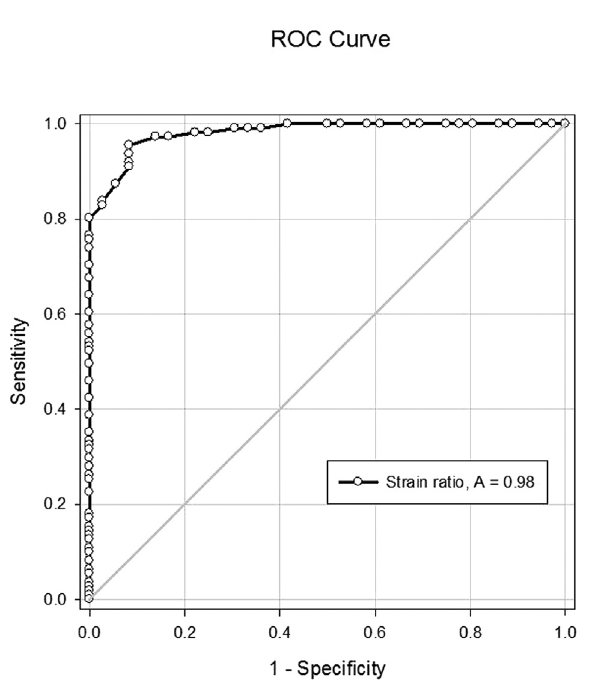
ROC curve for strain ratio to differentiate malignant and benign lymph nodes